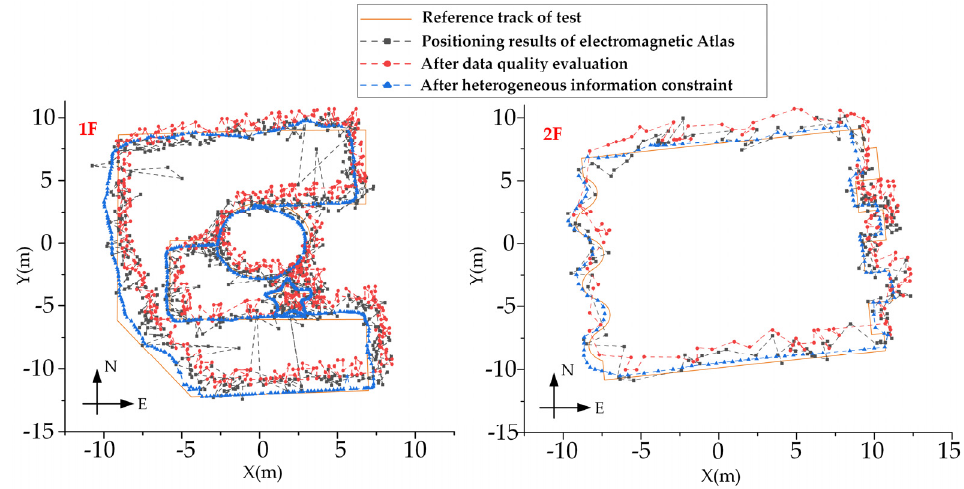
Figure 18. Positioning trajectory considering the credible evaluation mechanism.